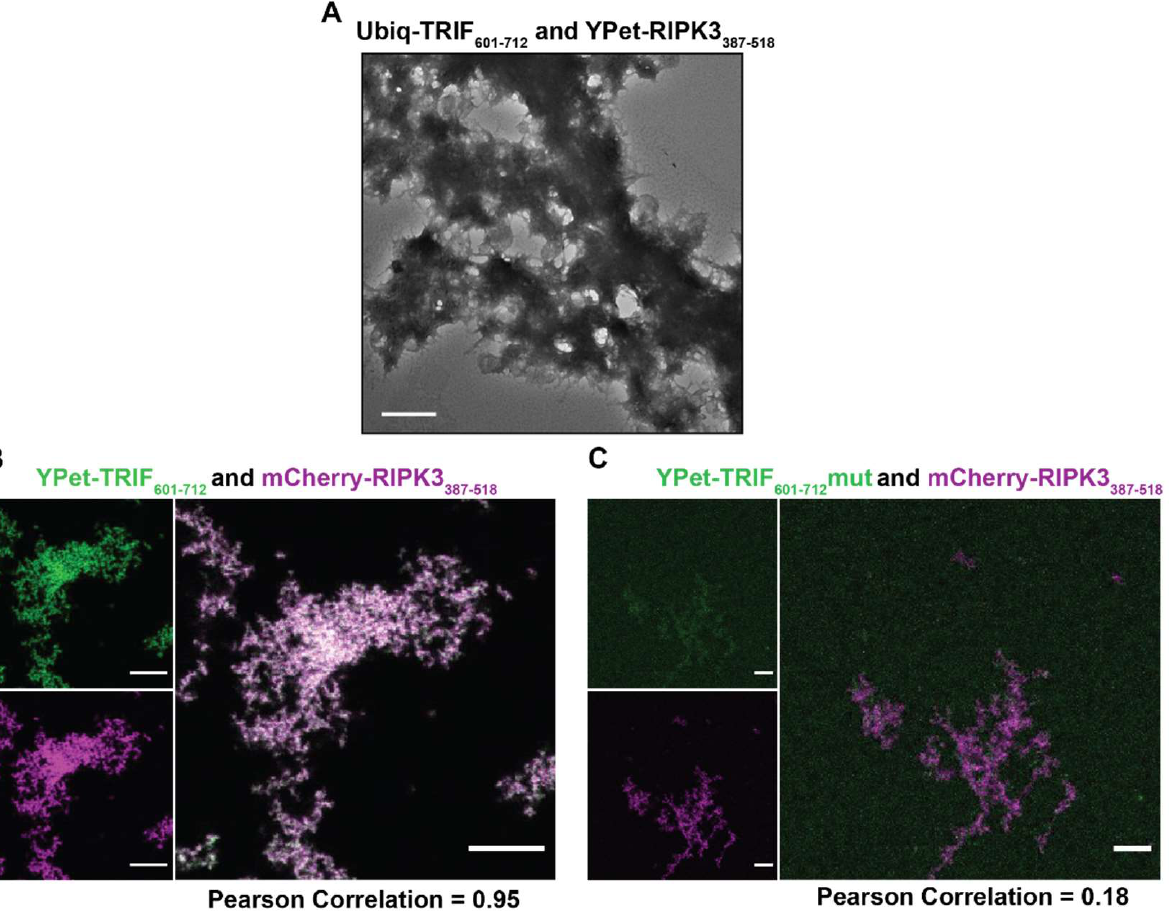
Figure 7. Confocal and transmission electron microscopy of mixtures of TRIF and RIPK3. ( A ) Trans- mission electron microscopy of mixtures of 1 µM Ub-TRIF 601–712 and mCherry-RIPK3 387–518 . Scale bars represent 500 nm. ( B , C ) Confocal images of mixtures of 2.5 µM TRIF 601–712 wt and TRIF 601–712 mut and RIPK3 387–518 RHIM-containing proteins. Images are displayed as recorded in GFP channel, mCherry channel and merged. Scale bar indicates 10 µm. Image analysis performed in Fiji. Pearson correlation determined by JaCoP plugin.